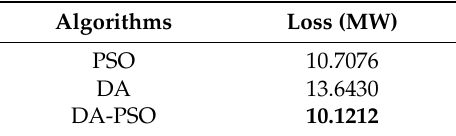
Table 8. Comparison of the results from DA-PSO and its traditional algorithms when considering only transmission losses as part of the objective function for the IEEE 57-bus